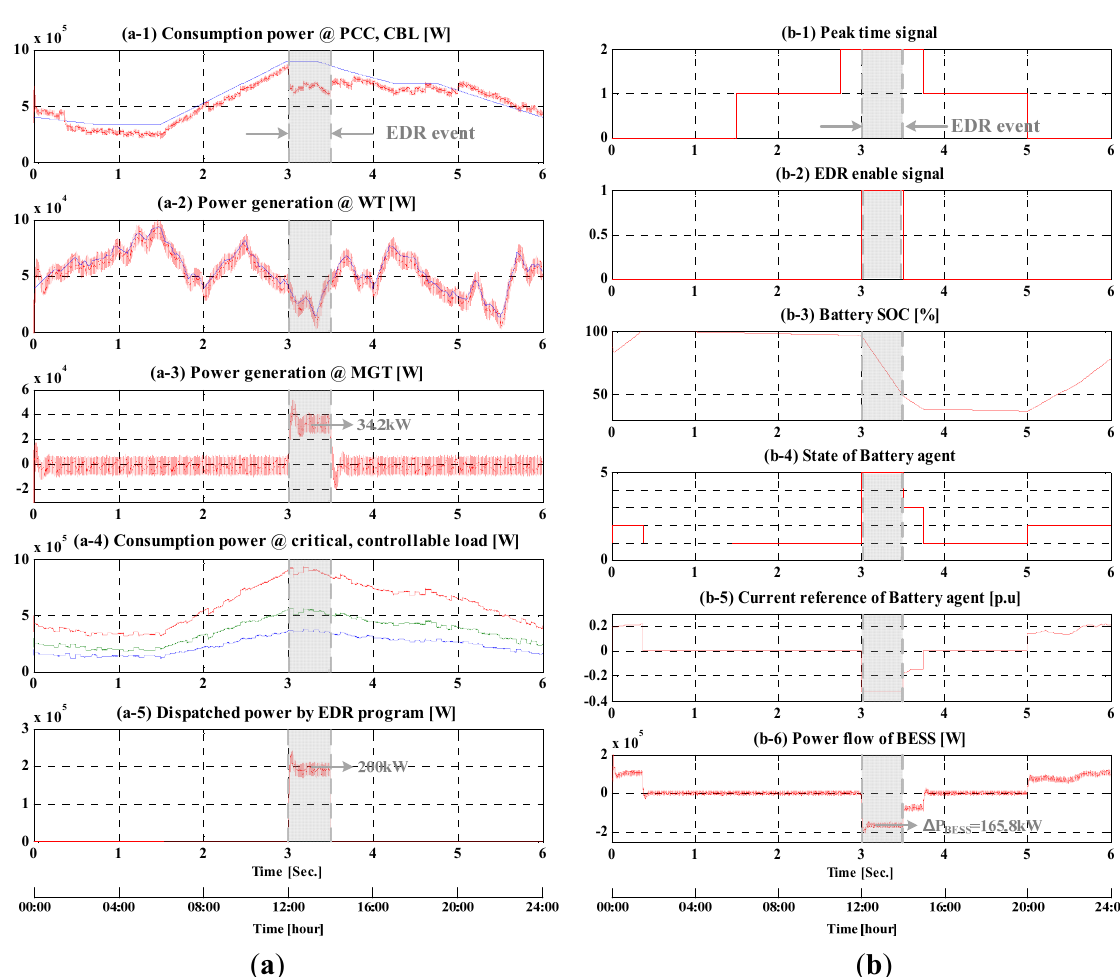
Figure 15. Simulation results in case 2. ( a ) Power flow of microgrid; ( b ) Signal process of BESS